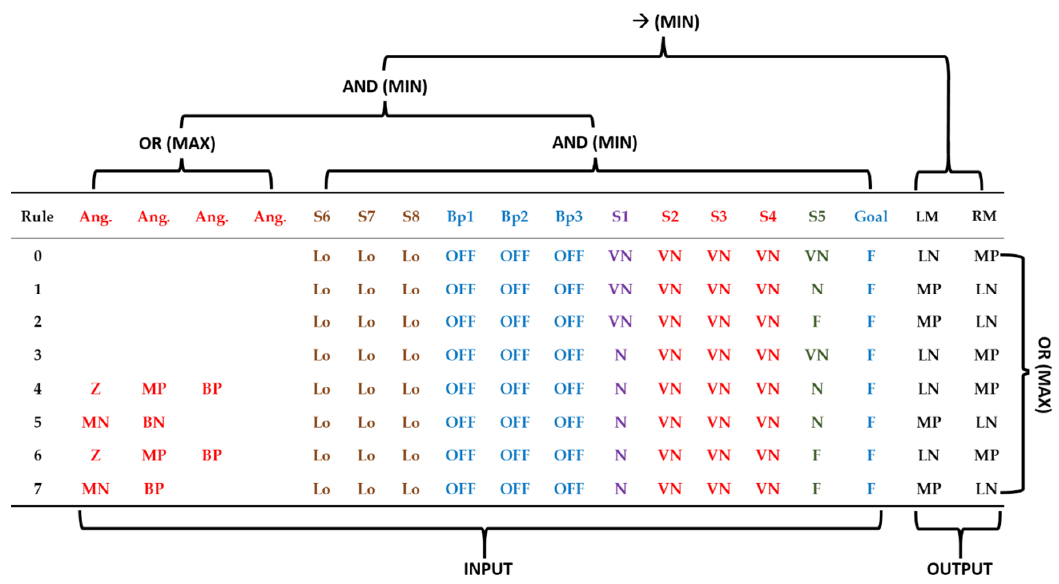
Figure 15. Example of application of operators for the composition of rules.